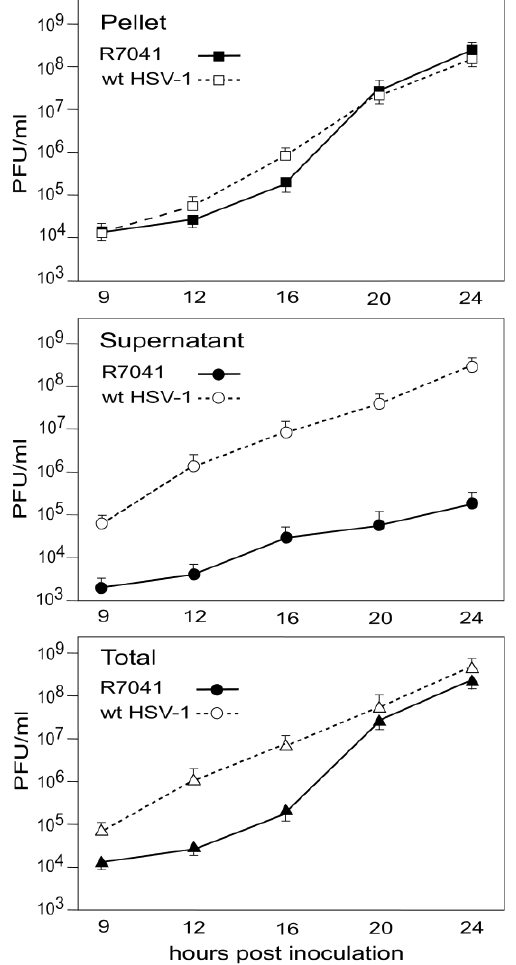
Figure 12. One-Step growth curves of R7041(∆Us3) and wt HSV-1. Cells were harvested at times post inoculation as indicated. Infectious virus yields in pellets and supernatants were determined by plaque titration. Mean and standard deviation were calculated from 4